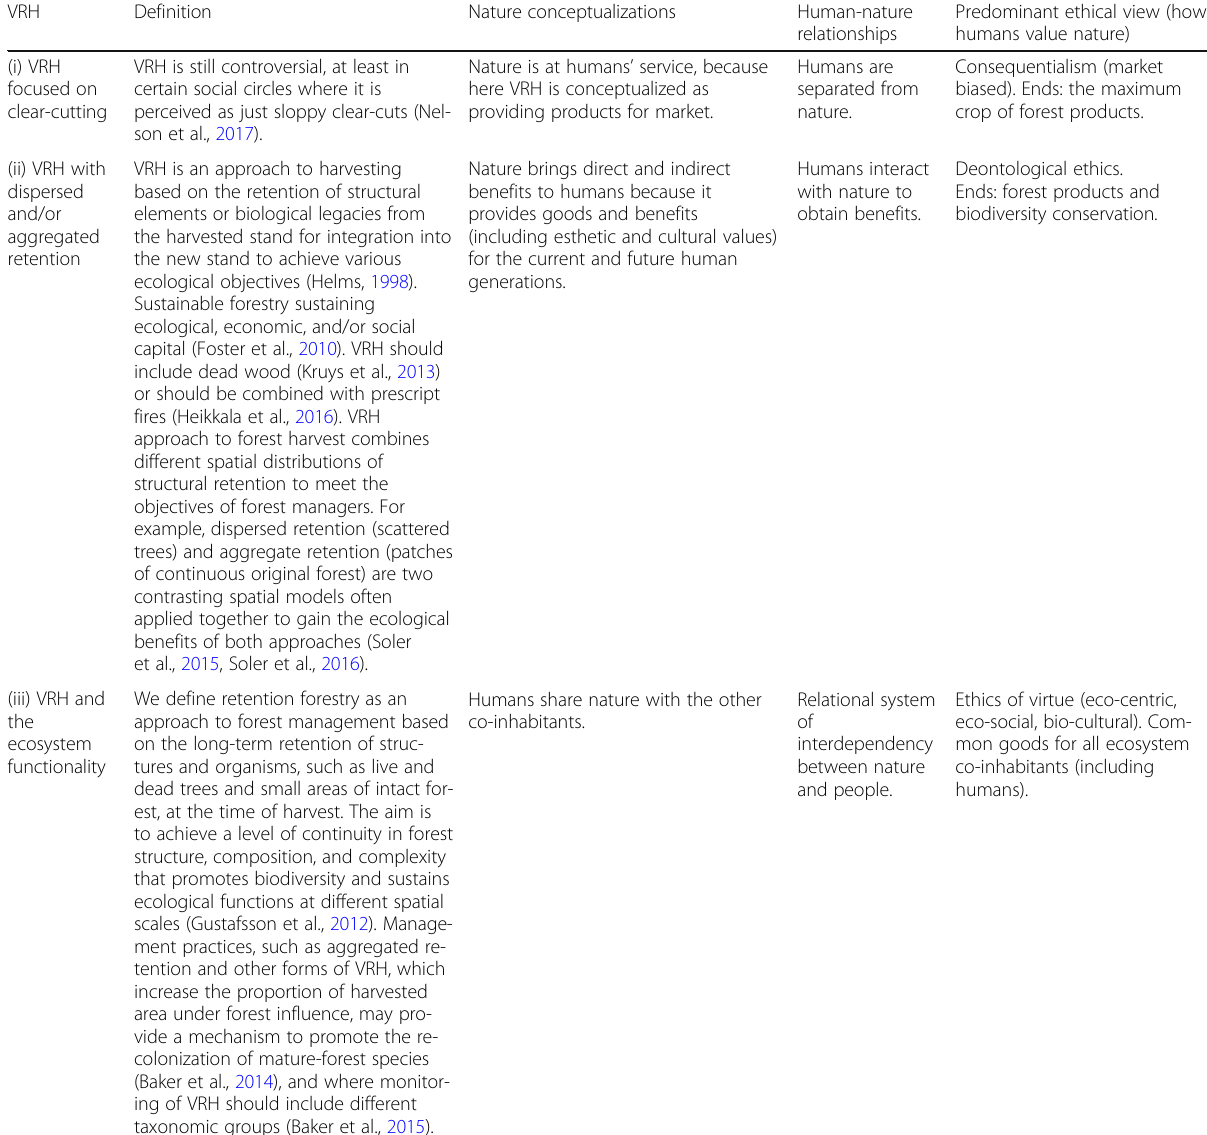
Table 2 Summary of the valuation modes beyond some conceptualizations for variable retention harvesting (VRH). Some examples of different definitions are included (see